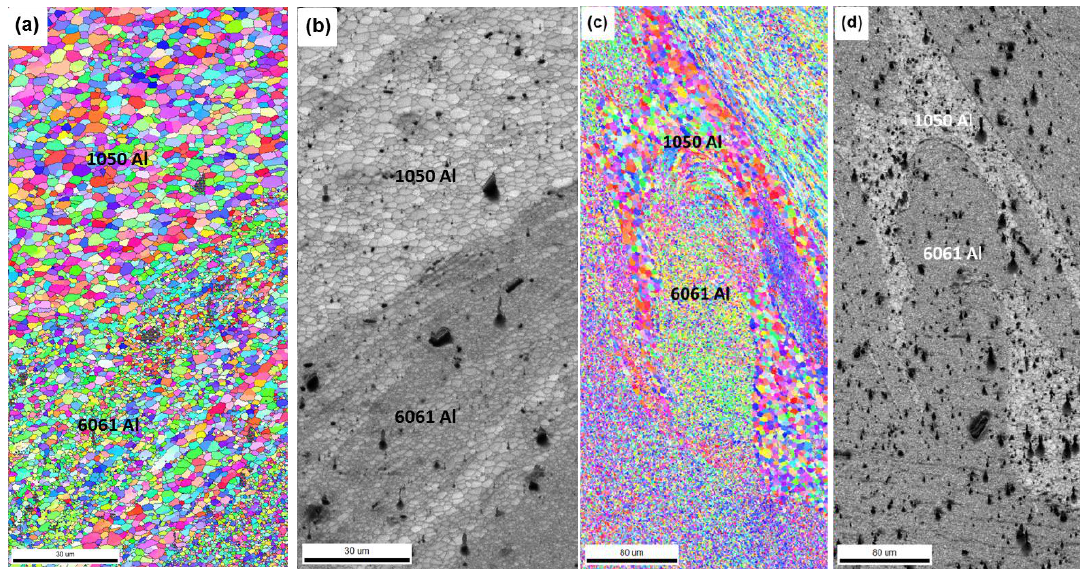
Figure 8. Electron backscattered diffraction (EBSD) map showing the microstructure of the stir zone of the dissimilar FSW joint produced at the revolutionary pitches of ( a ) and ( b ) 0.75 mm/rev; ( c ) and ( d ) 0.5 mm/rev.